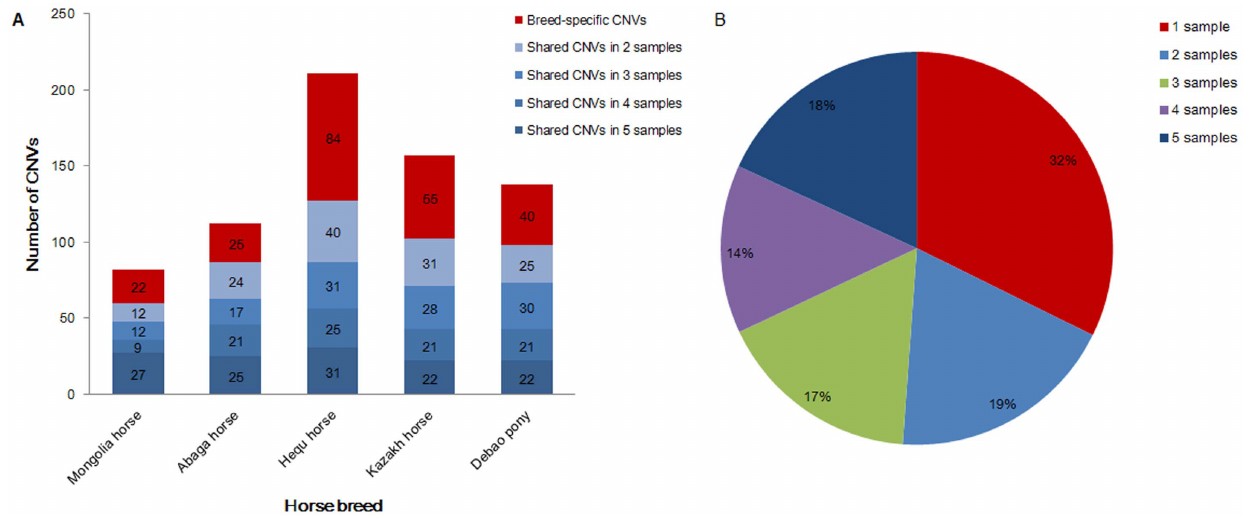
Figure 1. Distribution of CNVs in different breeds. (A) Distribution of breed-specific and shared CNVs among diverse horse breeds. The red represents breed-specific CNVs. The blue represents shared CNVs, and the color from light to dark indicates CNVs shared between 2, 3, 4 and 5 samples. (B) Percentage of CNVs shared among samples. The red represents 1 sample. The blue represents 2 samples. The green represents 3 samples. The purple represents 4 samples. The dark blue represents 5 samples.